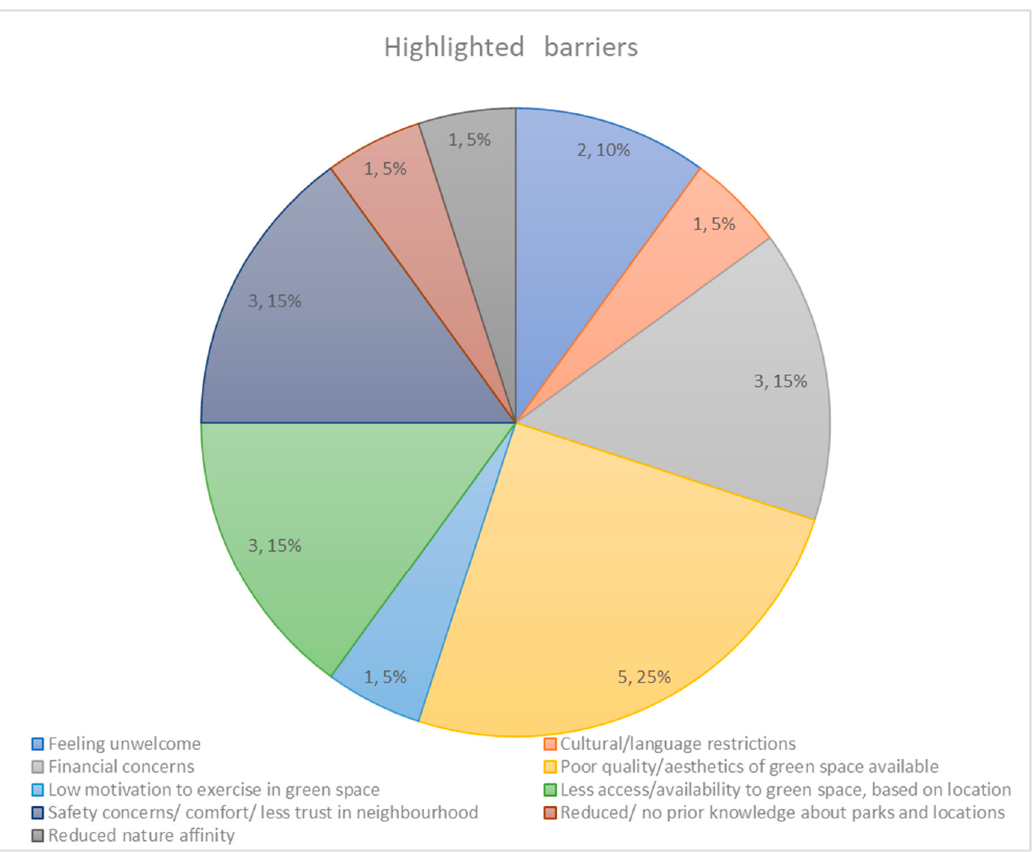
Figure 2. provides a visual overview of the themes of the main barriers experienced by racialised communities in relation to green space